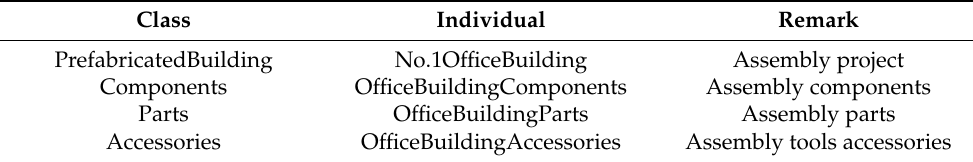
Table 7. Example of class-individual